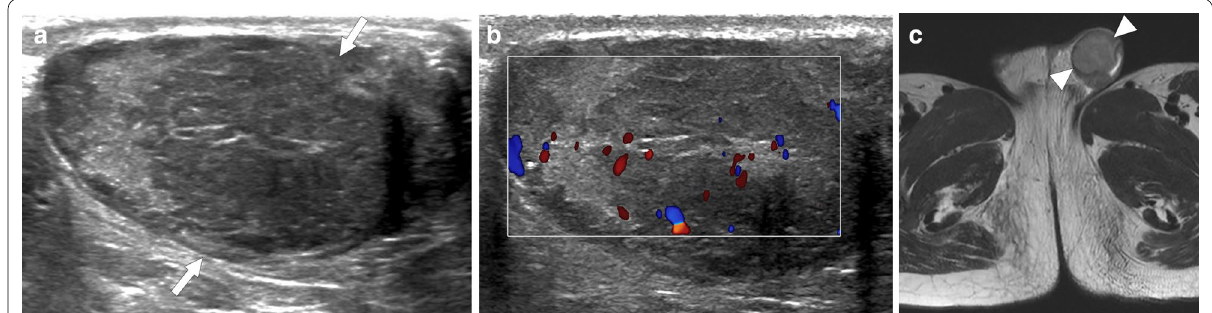
Fig. 5 Tuberculous orchitis. A 13-year-old male with known inherited interleukin-12 receptor deficiency and recently diagnosed disseminated tuberculosis. Patient also complained of mild left testicular pain and asymmetric enlargement at his initial presentation. a Gray scale US image shows ill-defined heterogeneous hypoechoic areas (arrows) almost completely replacing the parenchyma. b Color flow Doppler US demonstrated mild-to-moderate vascularity within these hypoechoic areas. c Axial T2-weighted MR image shows enlarged left testis with irregular borders and low T2 signal intensity (arrowheads). Based on the clinical, microbiological and radiological findings, the putative diagnosis was tuberculous orchitis. Serial follow-up US examinations after the start of antituberculosis treatment demonstrated gradual testicular atrophy